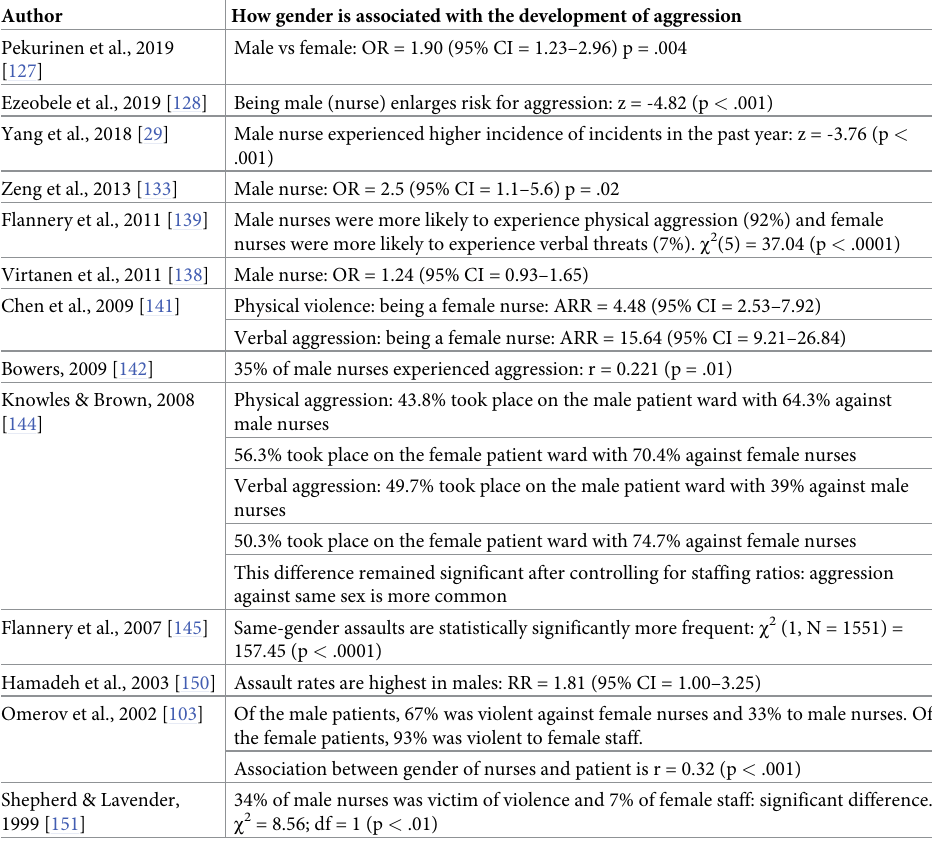
Table 5. Included studies on the association of gender of staff and aggression development in